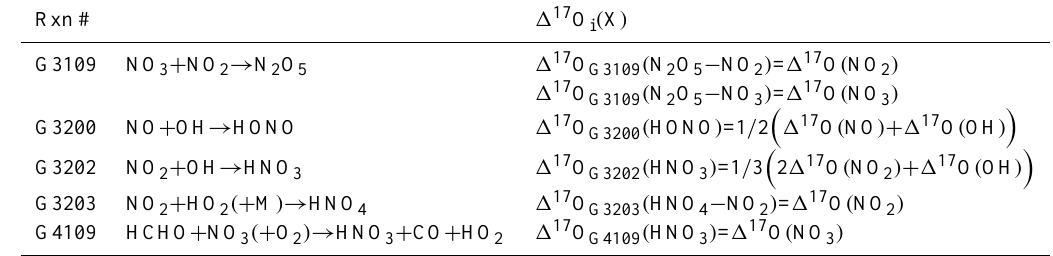
Table 1. Listing of 1 17 O i ( X ) relevant to Case 1 (PSS NO x ), if not given in Sect. 3.2.1. Note the special case of HNO 4 and N 2 O 5 , for which the 1 17 O of each of the molecule making up the dimer are explicitly referred to and